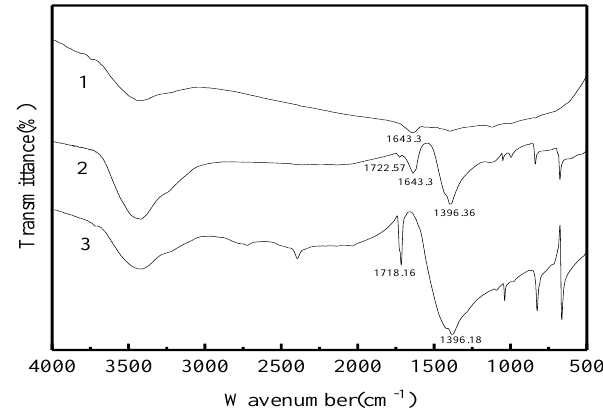
Figure 4. Infrared spectra of different samples: ( 1 ) Pure galena mineral; ( 2 ) Sulfidized Cerussite; ( 3 ) Pure cerussite mineral.